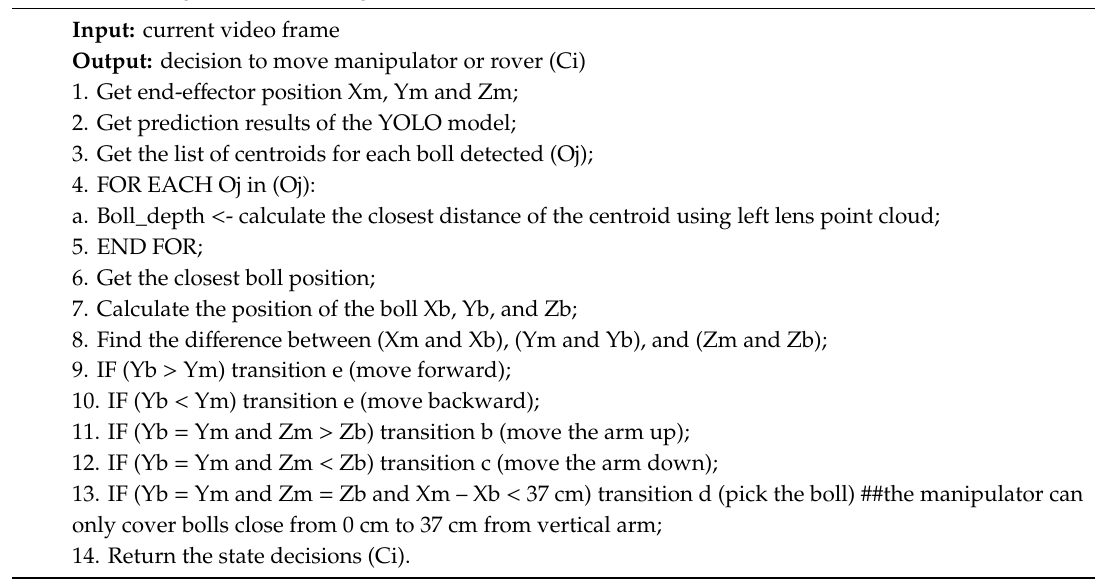
Algorithm 1 Algorithm describing the detection of cotton bolls.